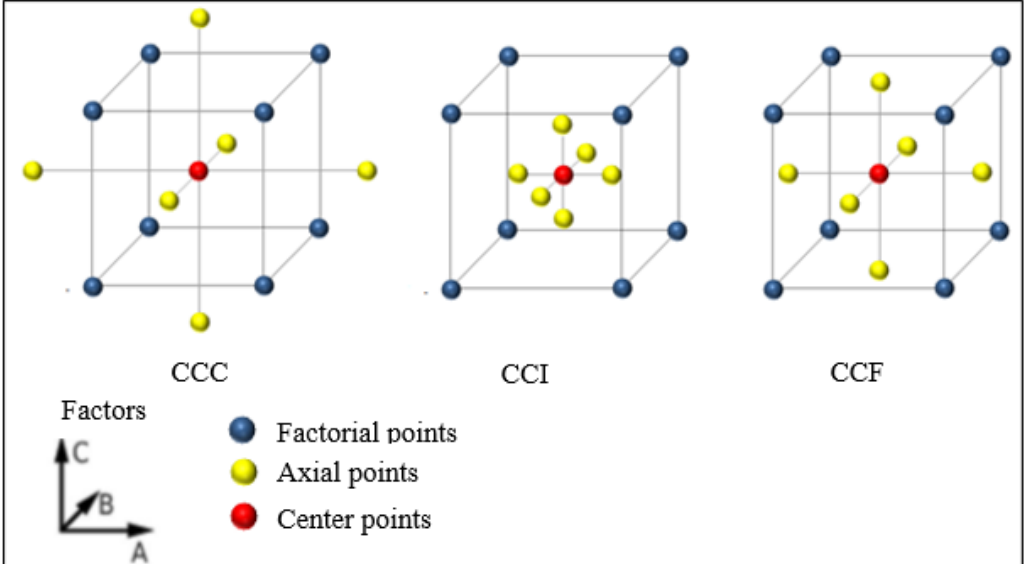
Figure 5. Central composite design (CCD) classifications [37].